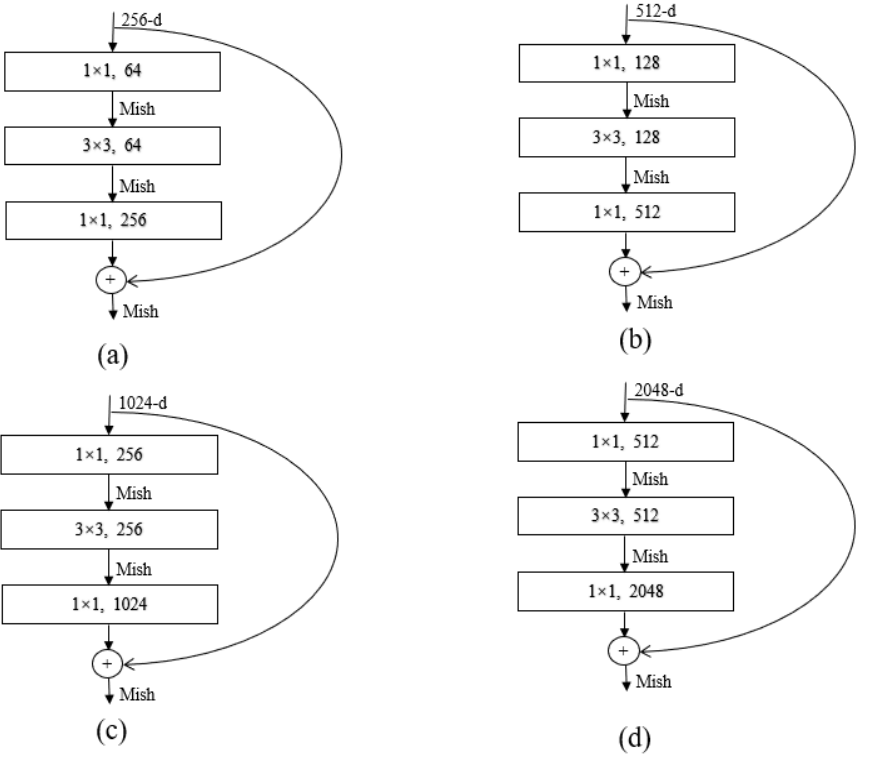
Figure 2. Bottleneck residuals module of different layers for the ResNet-50 architecture. ( a ) Stage 2, ( b ) stage 3, ( c ) stage 4, ( d ) stage 5.